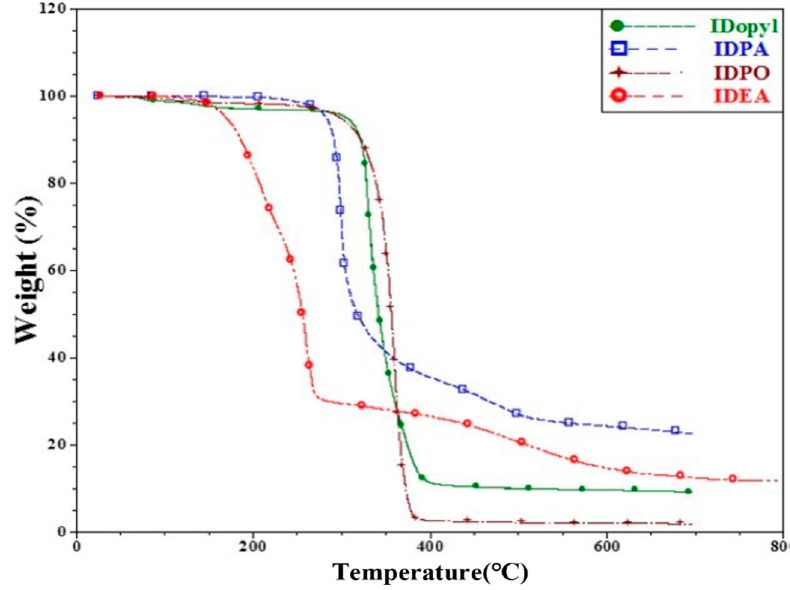
Figure 3. Thermal Degradation of Isosorbide bis -Phosphorus Esters.